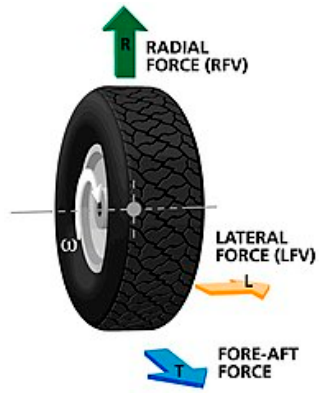
Figure 1. Tyre model.